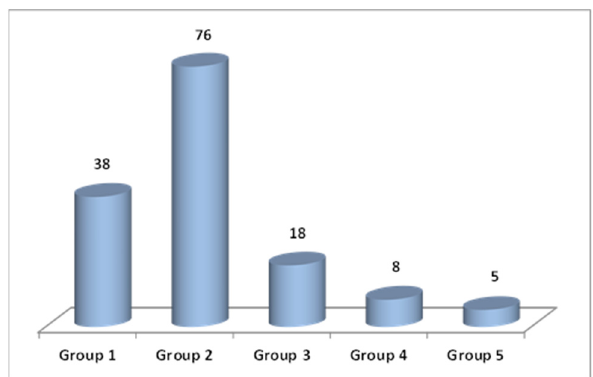
Figure 2. Number of cities of each group.